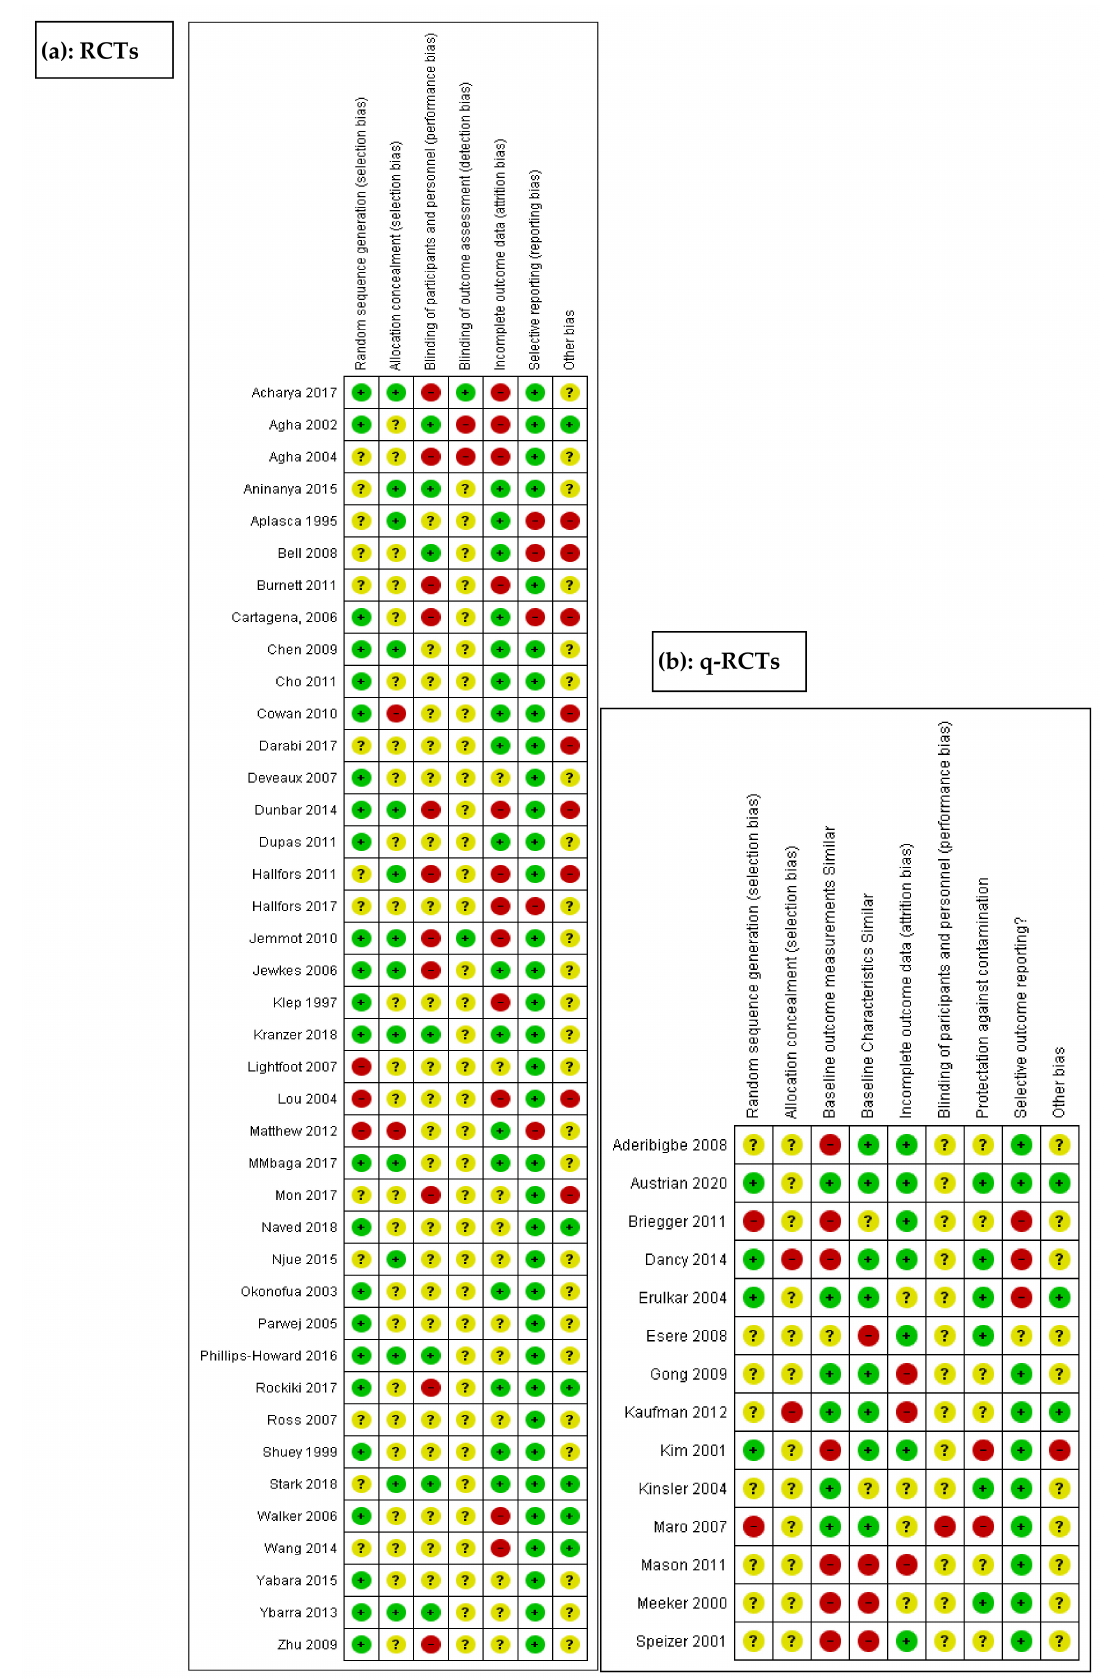
Figure 2. Methodological quality of the 54 studies ( a ) RCTs, ( b )